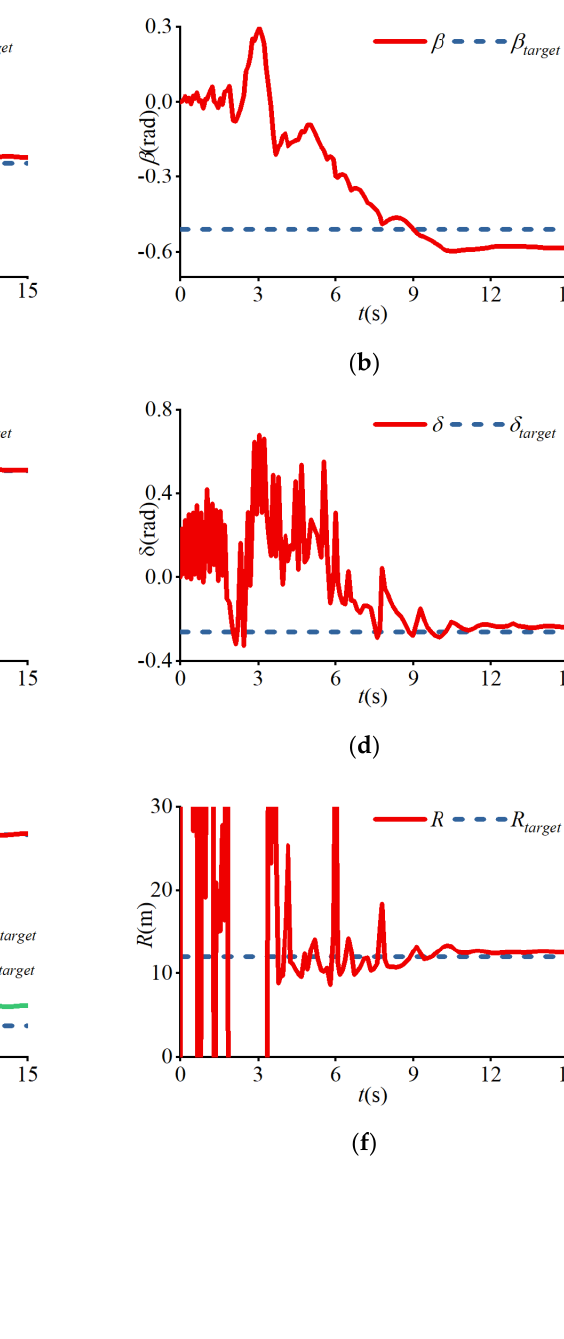
Figure 6. The simulation result with the 6 m/s original velocity and the target group (c): ( a ) the ve- locity; ( b ) the sideslip angle; ( c ) the yaw rate; ( d ) the steering angle; ( e ) the TYDEX longitudinal slip ratios of the front and rear tires; ( f ) the radius of the motion curve; ( g ) the motion curve of the ve- hicle. All continuous lines suggest the simulation results, while the dashed lines suggest the tar- gets.